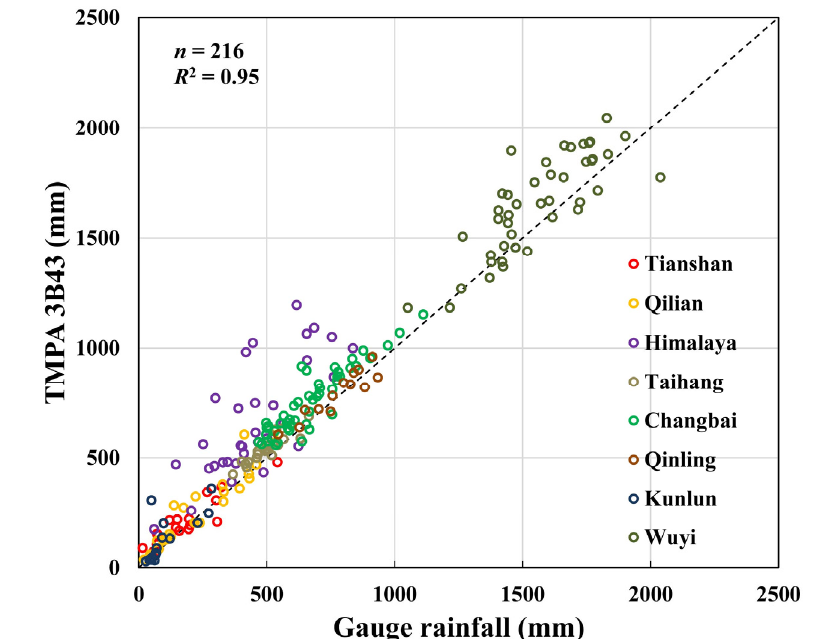
Figure 3. Validation of the mean annual rainfall (2001–2012) from gauge measurements and the original